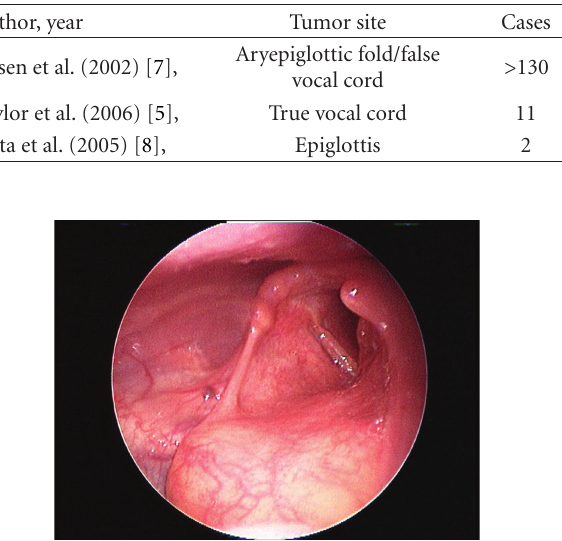
Figure 3: Fiberoptic laryngoscopy revealed a complete healing of the vocal cord. Laryngeal morphology and motility were